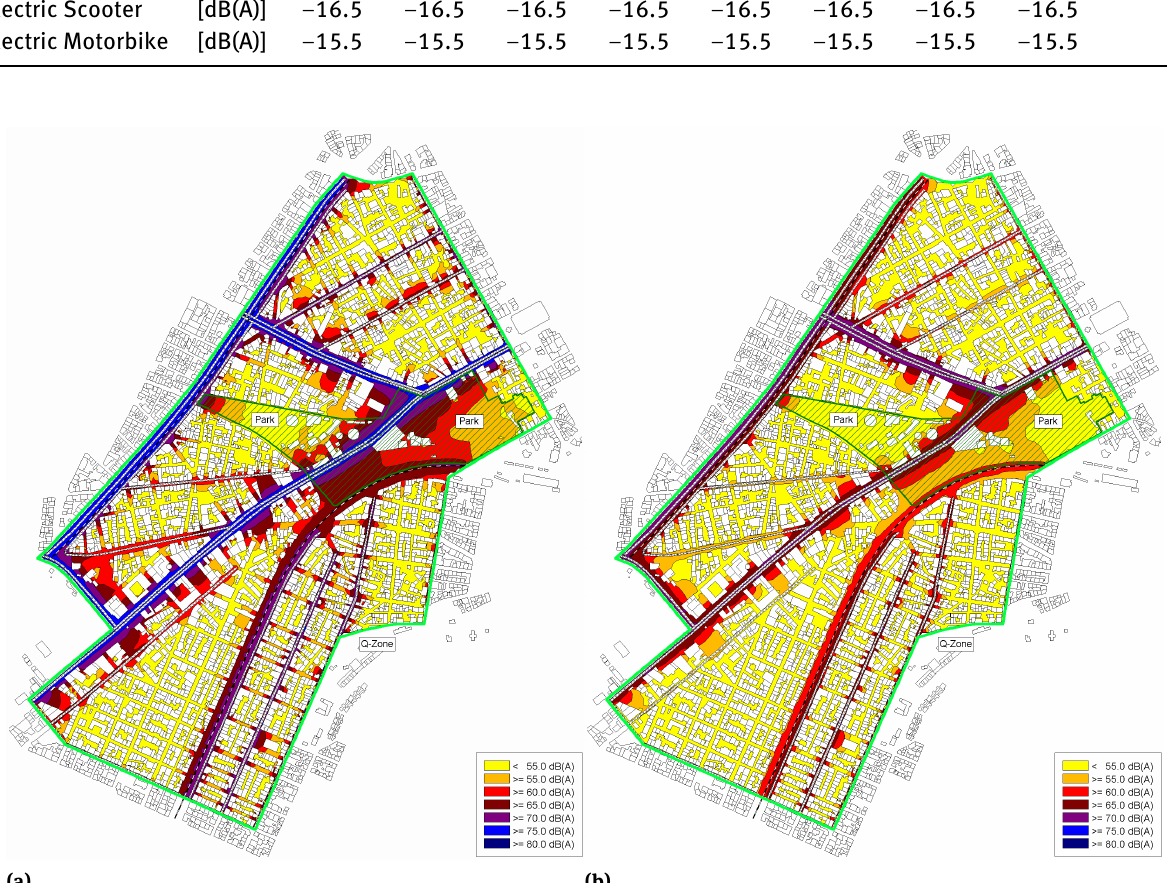
Figure 7: Scenario S02 - L